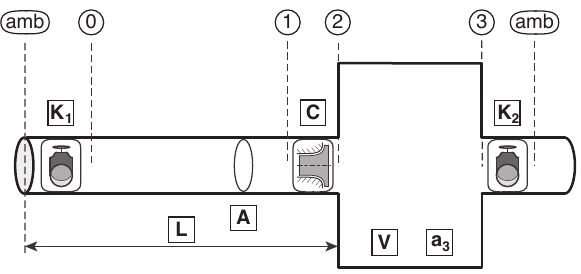
Figure 3. Simplification model of the compression